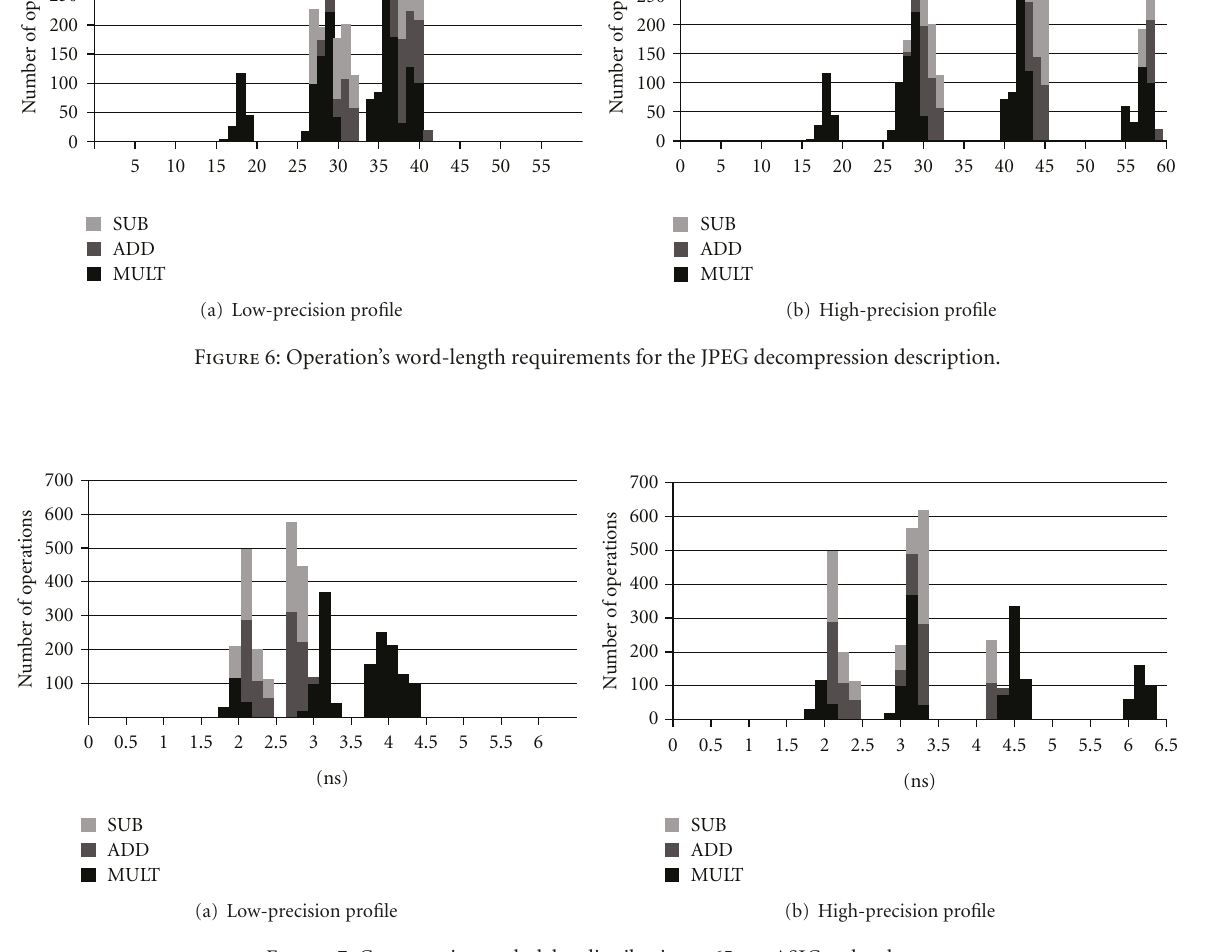
Figure 7: Computation path delay distribution—65nm ASIC technology.